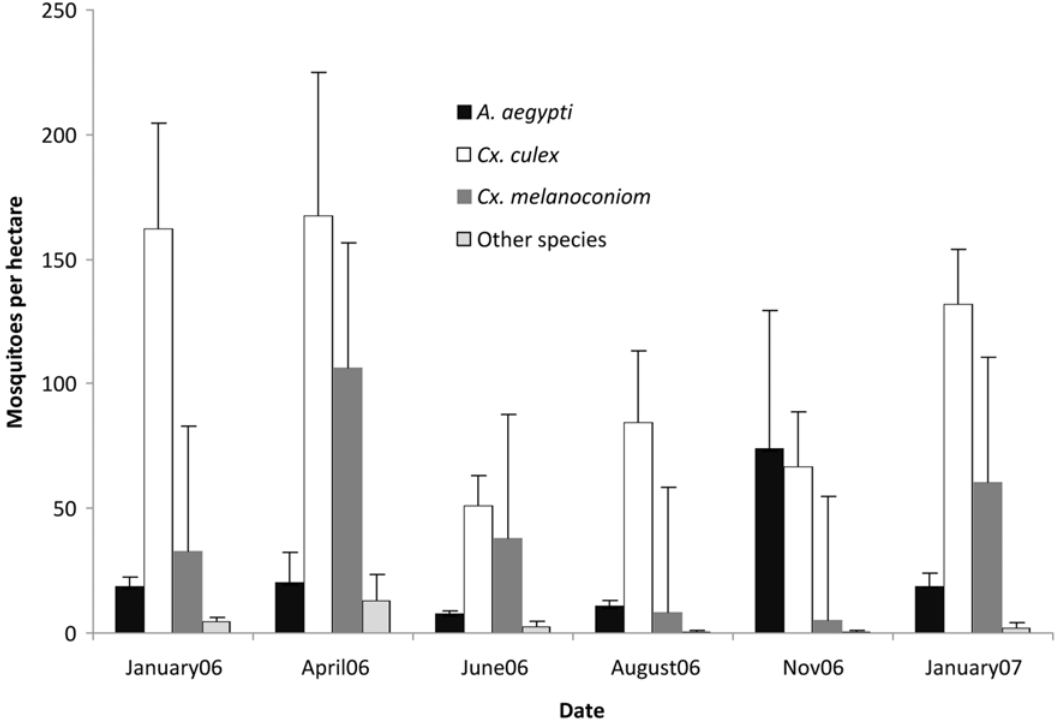
Figure 3. Population densities of mosquitoes collected during household entomological surveys. Mosquitoes were collected with backpack aspirators in house-to-house daytime surveys, carried out in 50 blocks distributed among 10 Ministry of Health zones. Results are represented as the mean ( 6 std error) of the number of mosquitoes collected per hectare surveyed. The other species category includes mosquitoes from the following genera: Aedomyia , Coquillitidea, Psorophora, Uranotaenia, Mansonia, Ochlerotatus, and